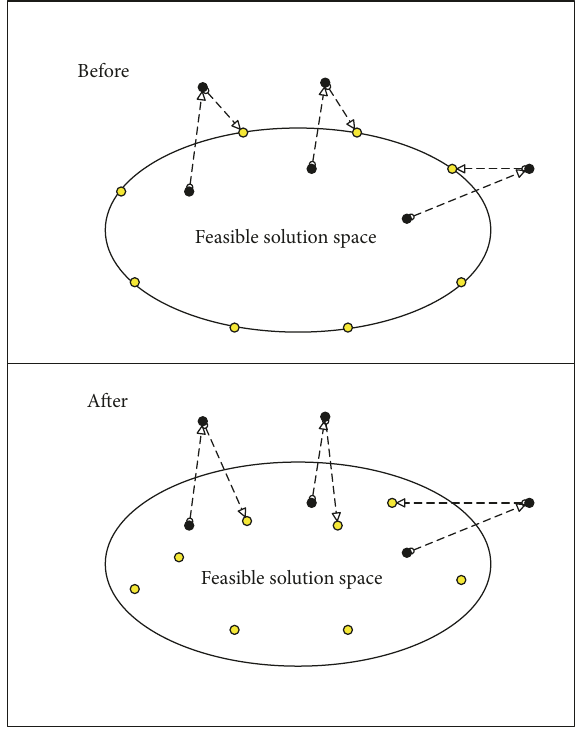
Figure 3: Improved boundary processing strategy.